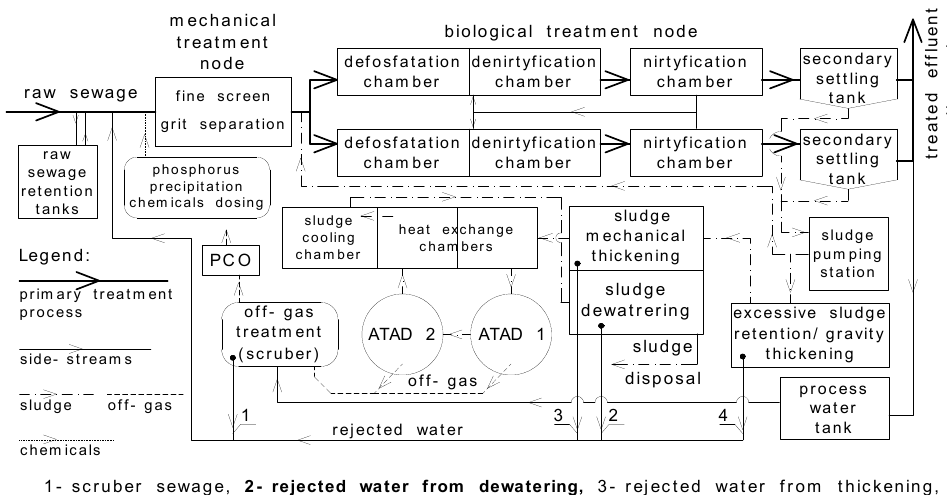
Figure 1. Simplified process flow diagram of WWTP1.